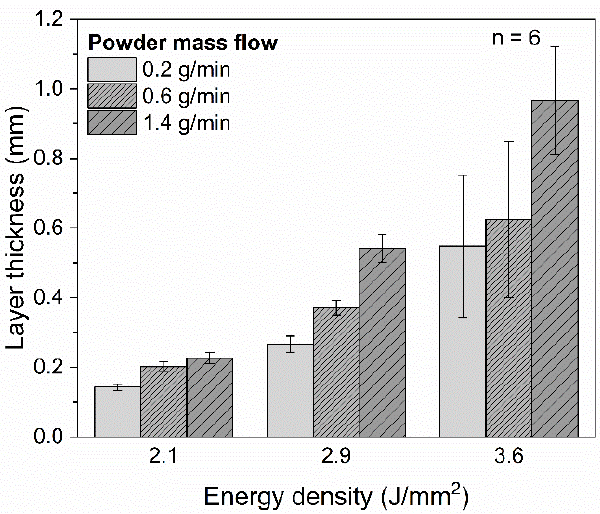
Figure 5. Layer thickness of the PA12 coatings on stainless steel substrates as a function of the energy density for powder mass flows of 0.2 g/min, 0.6 g/min and 1.4 g/min ( n = 6). When the energy density was raised from 2.1 J/mm 2 to 2.9 J/mm 2 , an increase by 86%, 84% and 139% in the layer height is observed for a powder mass flow of 0.2 g/min, 0.6 g/min and 1.4 g/min, respectively. Due to the higher energy input, an increased proportion of the powder particle stream was melted in the laser–powder interaction